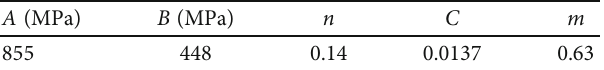
Table 2: Johnson – Cook model parameters for 15-5PH.